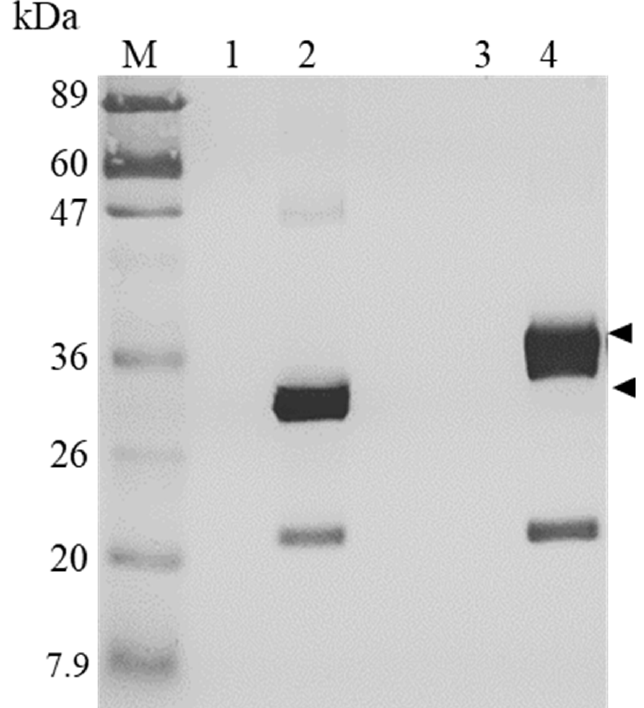
Figure 2. Western blot analyses of H1/FGF-7. (Lane M) Protein molecular weight marker; polyhedra (5 × 10 4 ) obtained from Sf21 cell culture infected with (Lane 1; CPH) recombinant baculovirus carrying cDNA of polyhedrin and (Lane 2; F7-PH) recombinant baculovirus carrying cDNA of H1/FGF-7 and polyhedrin. Sericin cocoons of 10 µg derived from (Lane 3; SC) the FH-P1A line and (Lane 4; F7-SC) the S1sp-F7 × FH-P1A line. Arrow heads indicate the position of H1/FGF-7.